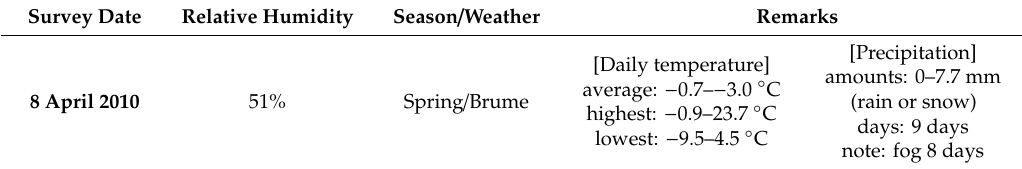
Table 3. Weather conditions of the pilot target bridge J for 14 days before the survey day (1) .